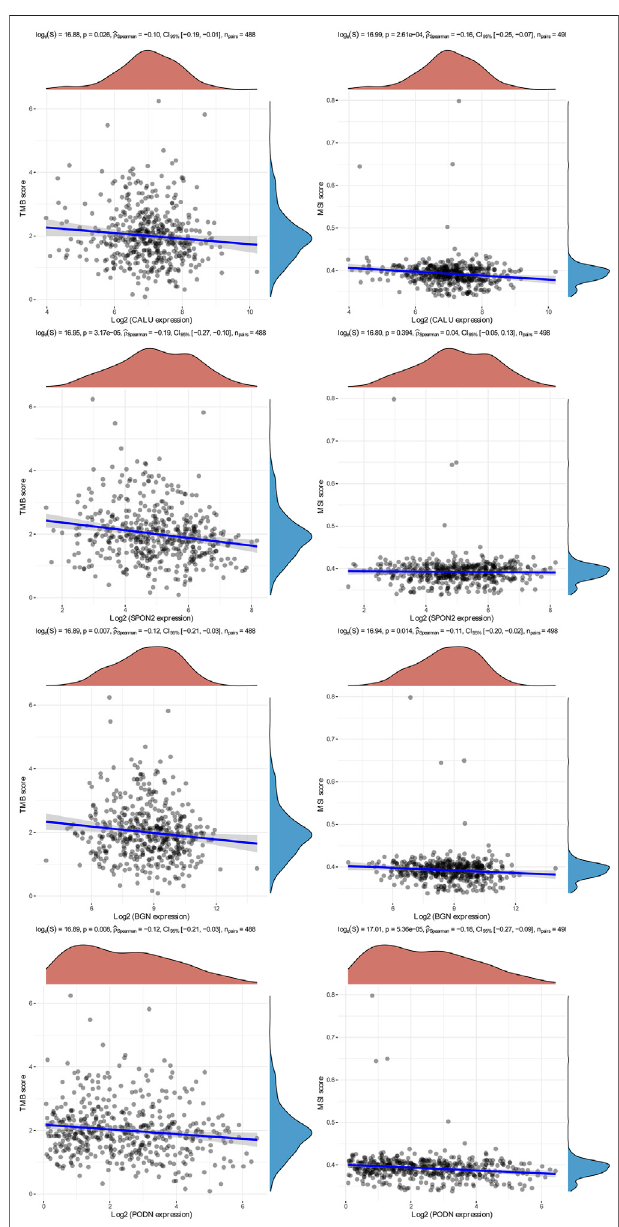
FIGURE 8 | The connection among the CALU, BGN, POND, SPON2, TMB, and MSI.